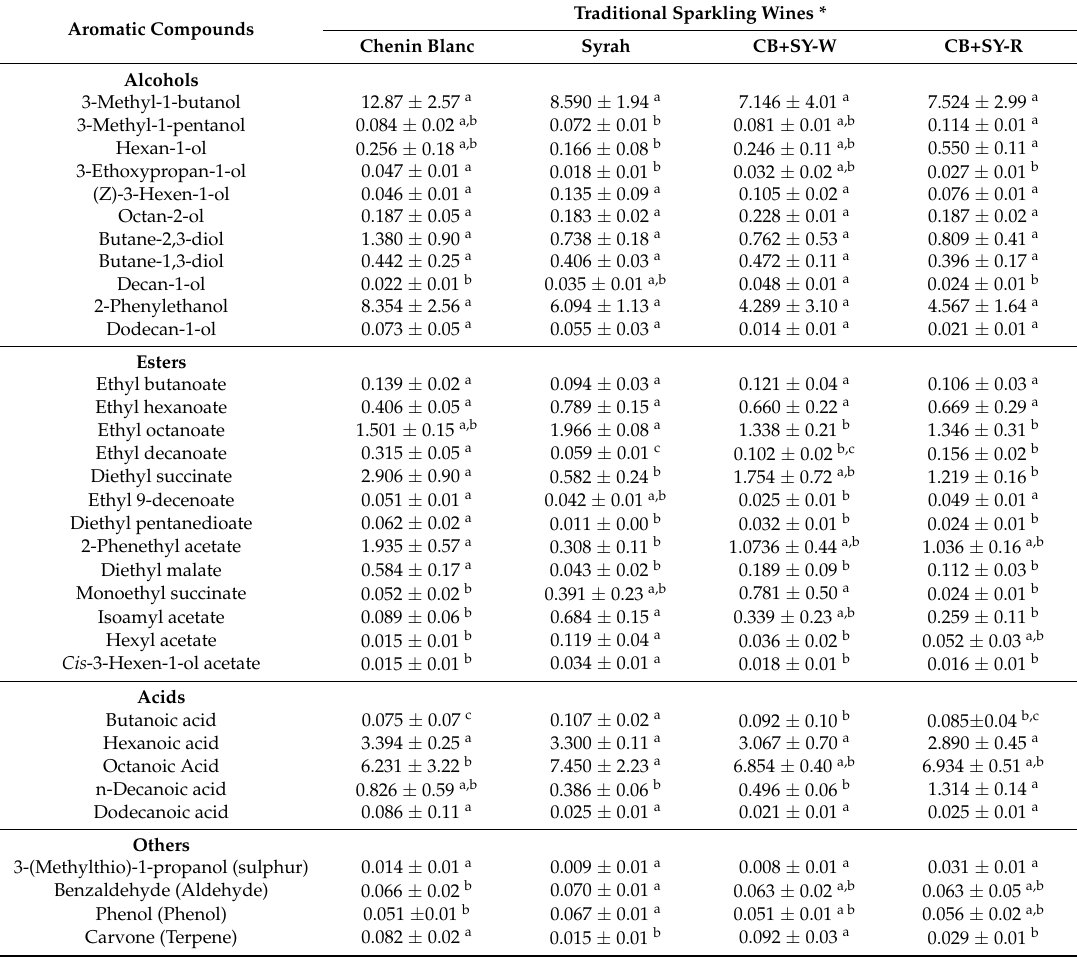
* The results are expressed as mean ± standard deviation of three sparkling wine bottles. Different letters on the same line indicate significant differences between samples (p < 0.05). CB+SY-W: sparkling wine 50%